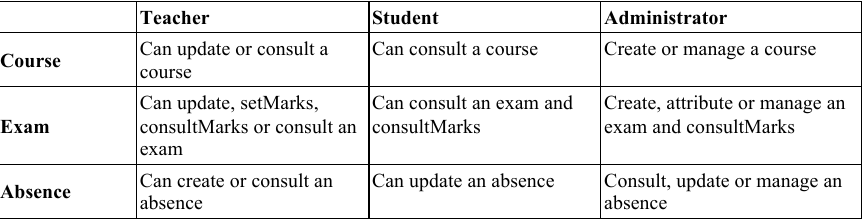
Table 1. User’s matrix of the School study case